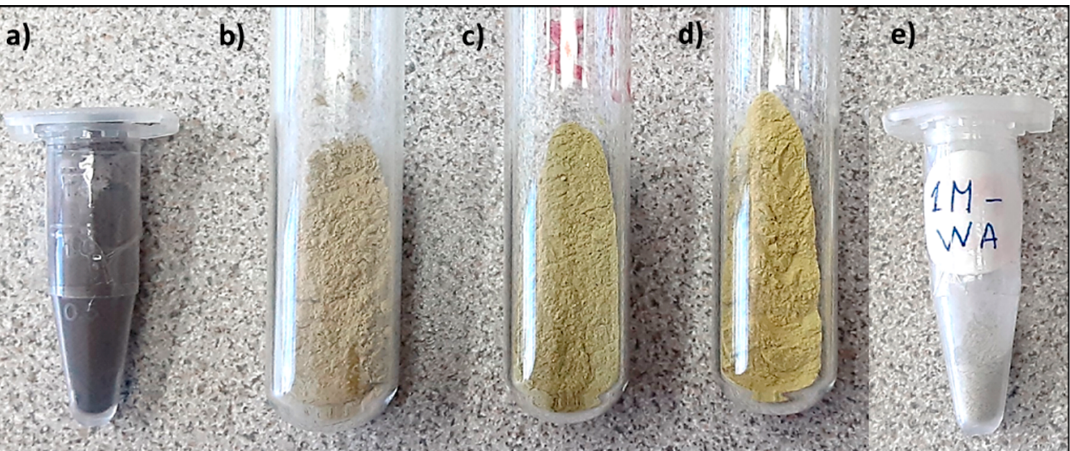
Figure 2. As-synthesized products after the reaction of the precursor sand with oxalic acid solutions at 155 °C and 50 bar: ( a ) sCW, ( b ) 0.1 M-WB, ( c ) 0.5 M-WB, ( d ) 1 M-WB, and ( e ) 1 M-WA (other WA powders have the same appearance of 1 M-WA).